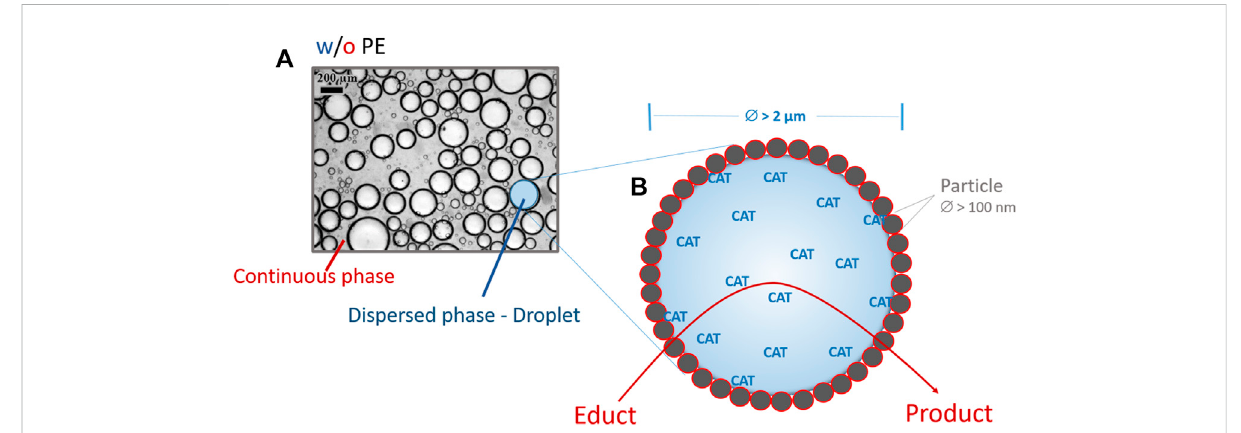
FIGURE 1 Pickering emulsion (PE) of the water-in-oil type (w/o). (A) Microscopic picture of a buffered aqueous phase (50 mmol · L − 1 KPi, pH 7.0) in cyclopentylmethyletheratavolumephaseratioof1:10containing3%(weightpervolumeofdispersedphase)silanizedsilicaparticles. (B) Schematic illustration of an aqueous droplet stabilized by solid particles and harboring a biocatalyst (CAT). Particle and droplet sizes denote typical values (Chevalier and Bolzinger,